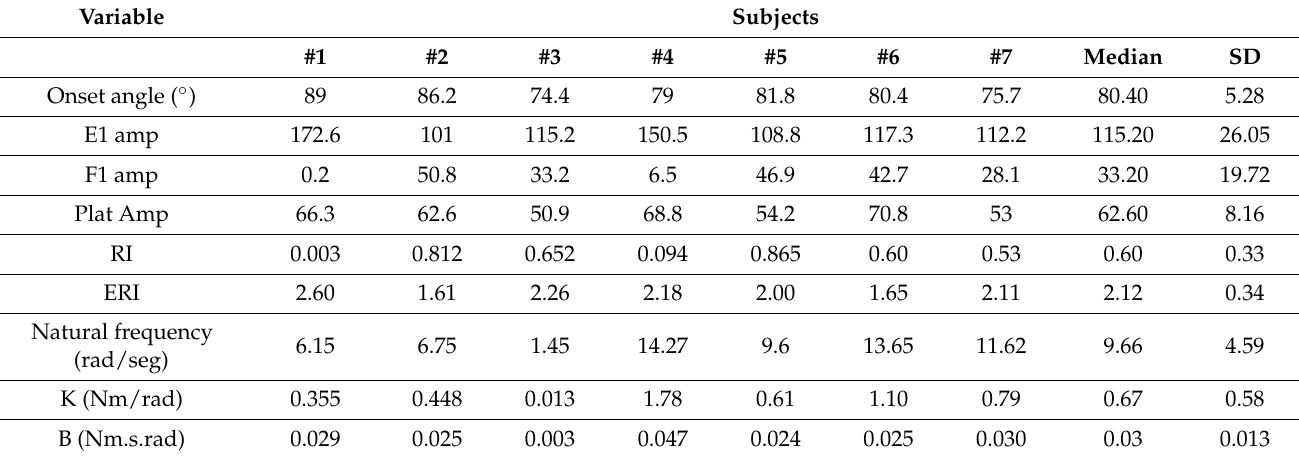
Table 4. Summary of the results concerning the onset angle, the amplitude of extension (E1 amp) and amplitude of flexion (F1 amp), the relaxation index (RI), and the extension relaxation index (ERI) during the pendulum